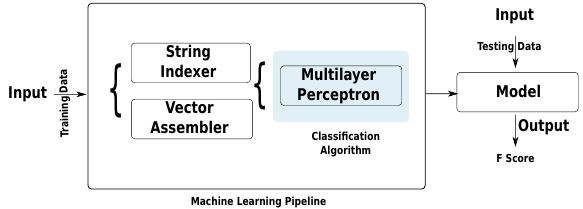
Figure 2. Machine Learning